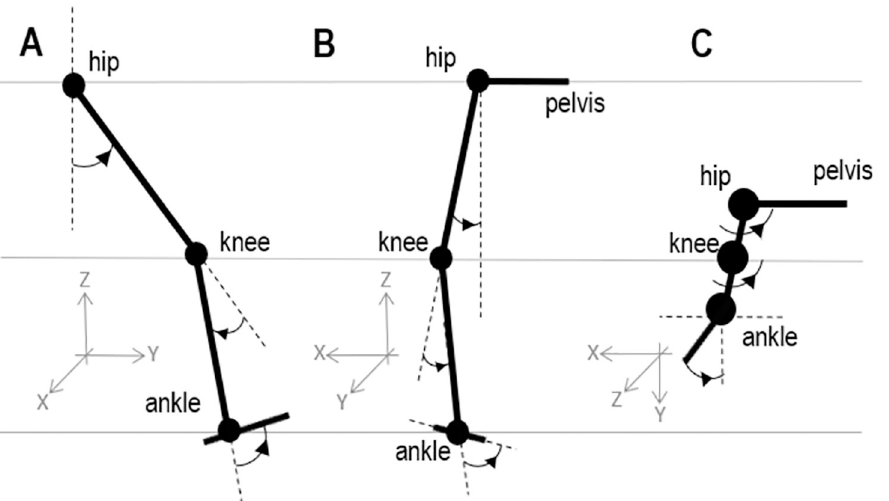
Fig 1. Definition of joint angles in three anatomical planes. For each angle, the arrow points in the direction of the positive angle (increase in angle value). Ankle angle was defined as the angle between the foot and shank segments; knee angle was calculated as the angle between the thigh and shank; and hip angle was calculated between the thigh and pelvis. A: Sagittal plane. In a neutral standing position when the foot is flat on the ground, ankle angle measures slightly less than 90˚; knee angle measures 0˚ when the shank and thigh are in a perfectly straight line; and hip angle measures close to 0˚. B: Frontal plane. C: Transverse plane. In both planes, frontal and transverse, ankle angle measures 0˚ when the foot and shank are in a perfectly straight line/the same plane, while knee and hip angles in these planes are 0˚ in a neutral anatomical standing